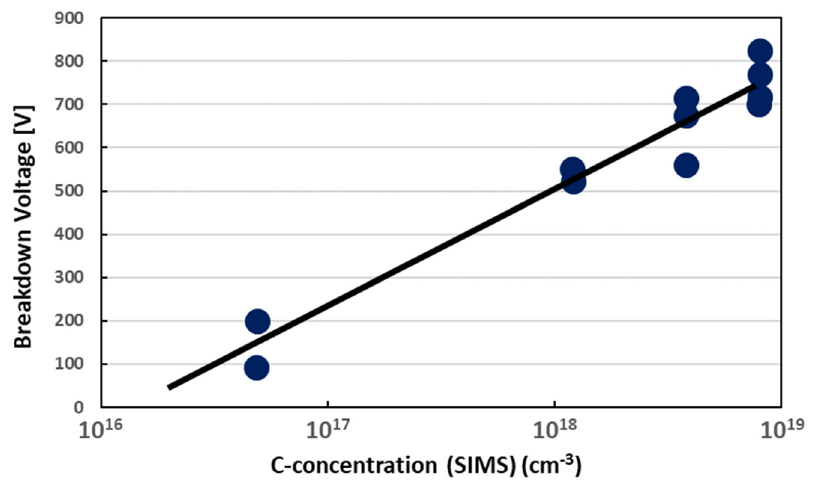
Figure 7. The relationship between breakdown voltage and Carbon doping concentrations in the GaN buffer layer [53]. Figure reproduced with permission from J. Cryst. Growth. GaN buffer layer [53] . Figure reproduced with permission from J. Cryst. Growth.